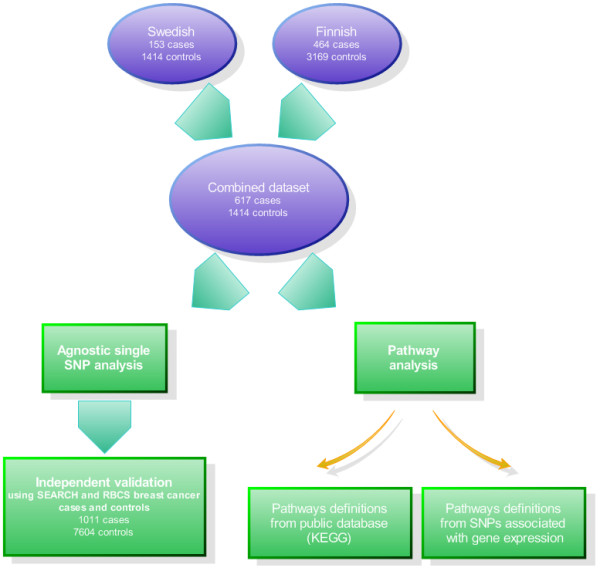
Schematic diagram of analytical strategies for agnostic single marker association analysis and pathway analysis.